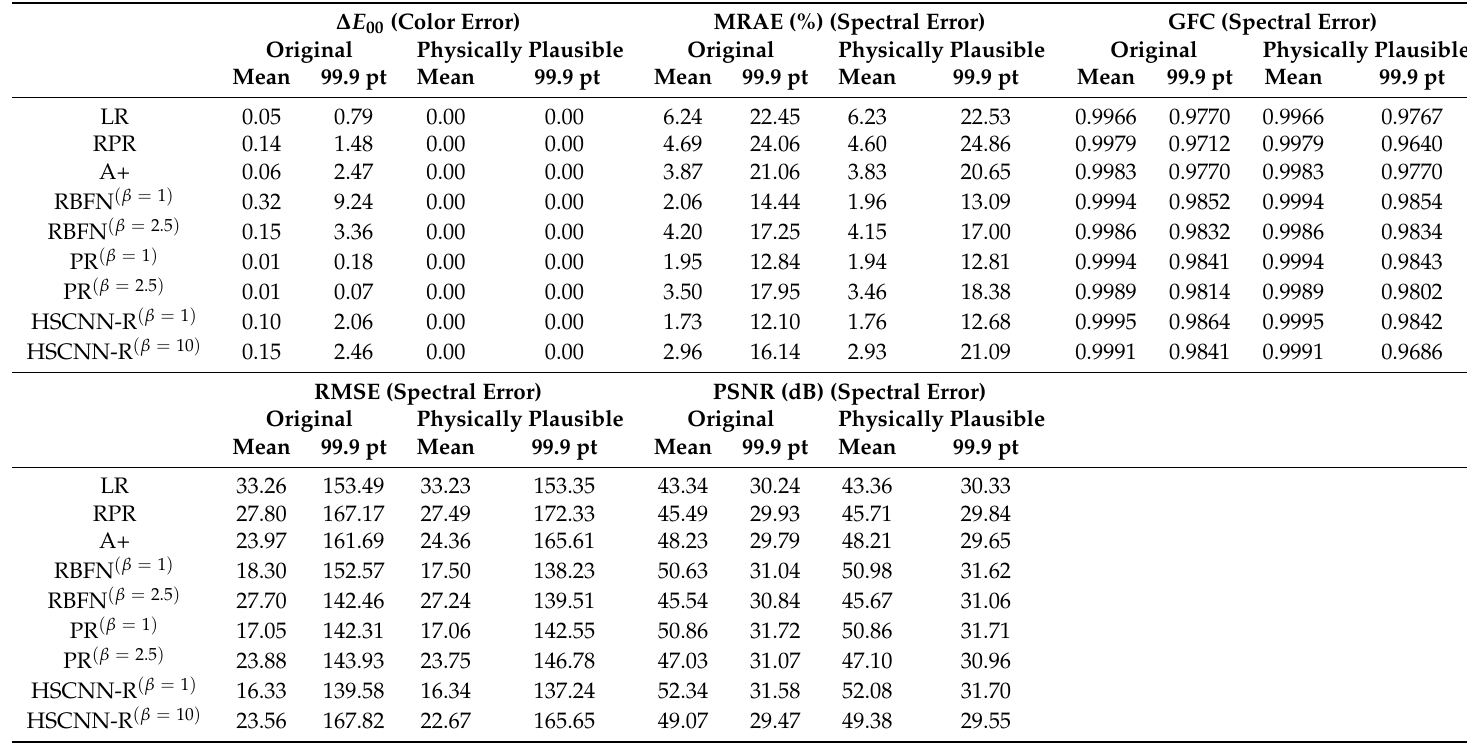
Table 3. The colorand spectral accuracy results as the averaged per-image mean and 99.9th percentile (pt). The results are shown respectively in ∆ E 00 , MRAE, GFC, RMSE and